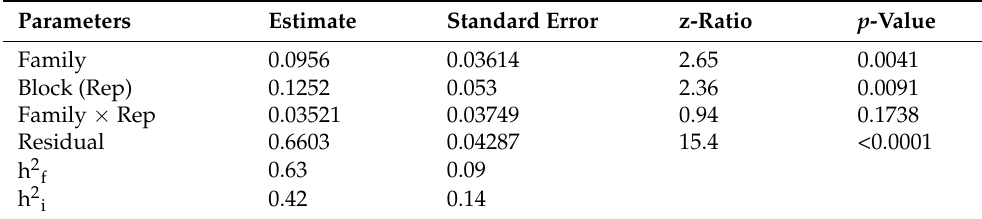
Table 2. Genetic variation in rust in Summer × Kanlow switchgrass population evaluated in the second and third generations in the field, near Mead, NE, in 2022.